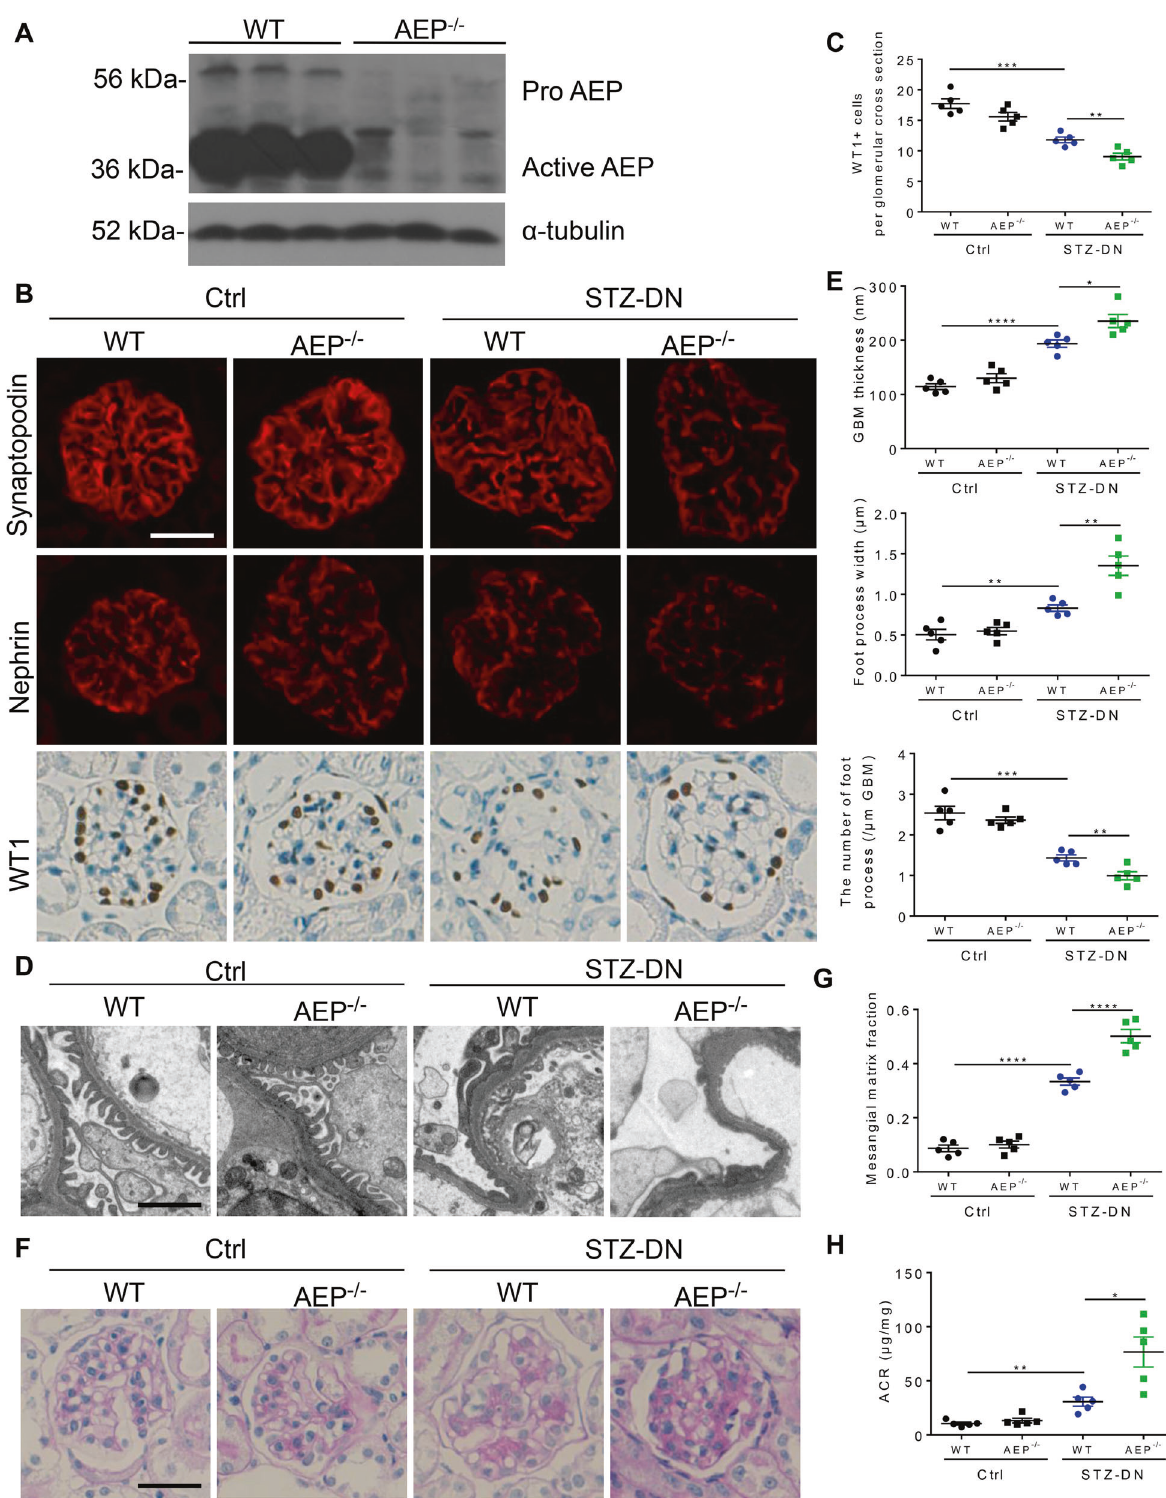
Fig. 2 Diabetic glomerulopathy was aggravated in asparaginyl endopeptidase (AEP) knockout mice. A Western blot of AEP levels in wild- type (WT) and knockout mice (AEP − / − ). N = 5. B Representative images for Synaptopodin, Nephrin, and WT1 in the control and STZ-induced glomeruli. Scale bar: 25 μ m. C Quantitative analyses of the number of WT1-positive cells. N = 5. D Representative transmission electron microscopy (TEM) images showing morphological changes in the podocyte foot process in different groups of mice. Scale bar: 2 μ m. N = 3. E Indices for glomerular fi ltration barrier integrity, including glomerular basement membrane (GBM) thickness, foot process width, and the number of foot processes/ μ m GBM. F Periodic acid-Schiff (PAS) staining showing glomerular morphological changes. Scale bar: 25 μ m. G Quantitative analyses of the percentage of mesangial matrix area. N = 5. H Urinary albumin to creatinine ratio (ACR) in different groups of mice. N = 5. **** P < 0.0001, *** P < 0.001, ** P < 0.01, * P < 0.05, data were represented as mean ± SEM.